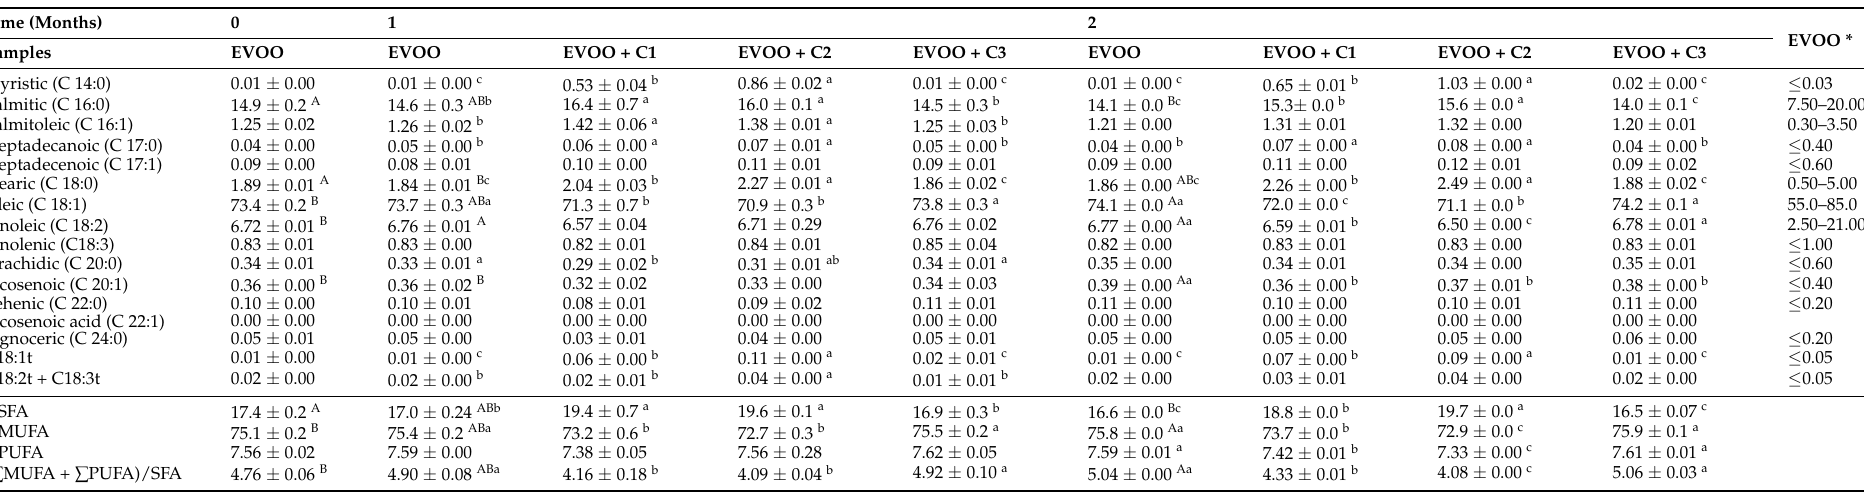
Table 3. Fatty acid profile (%) in extra virgin olive oils (EVOO) during storage with and without the addition of semi-hard (C1), hard (C2), and soft whey (C3)